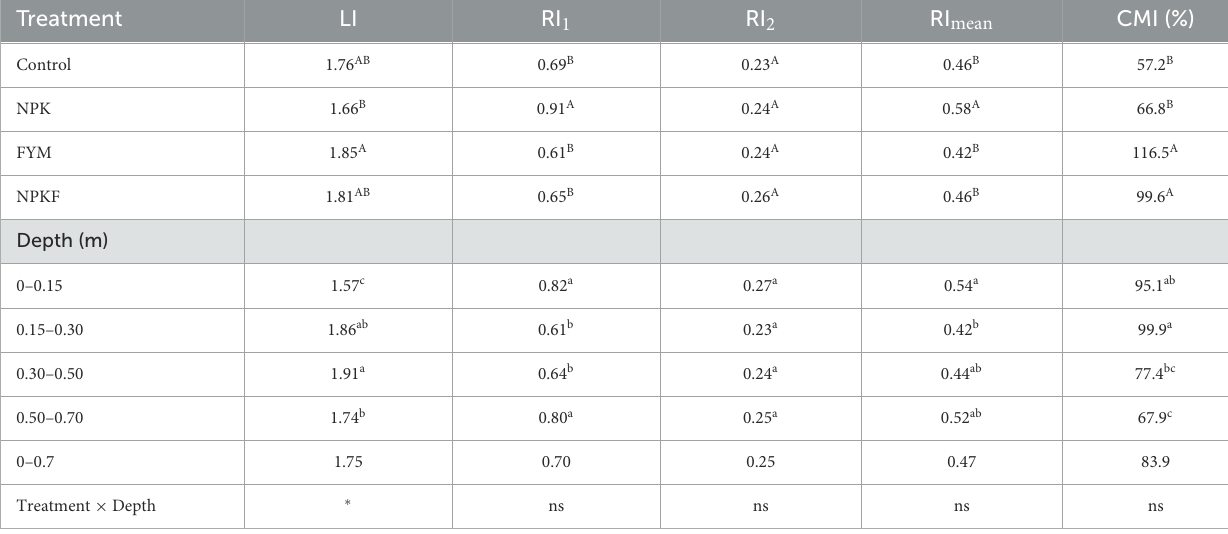
TABLE 4 Effect of nutrient management practices on lability index (LI), recalcitrant indices (RI), and carbon management index (CMI) in soil depth. Treatment